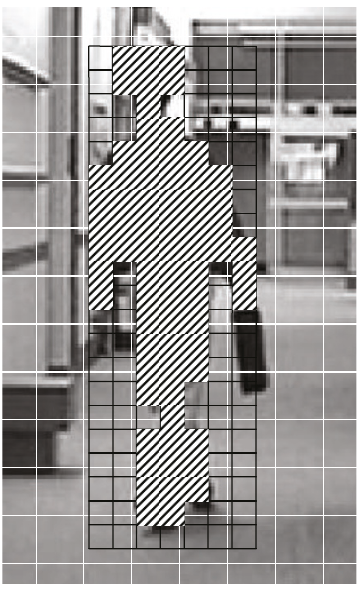
Figure 7: A part of a frame of the video sequence “hall monitor.” The black grid represents the cloaking layer which coincides with the ROI mask matrix T . The hatched parts indicate the cloaking matrix elements larger than zero. The motion vectors of the parts that are not hatched will not be used to determine the overall object motion